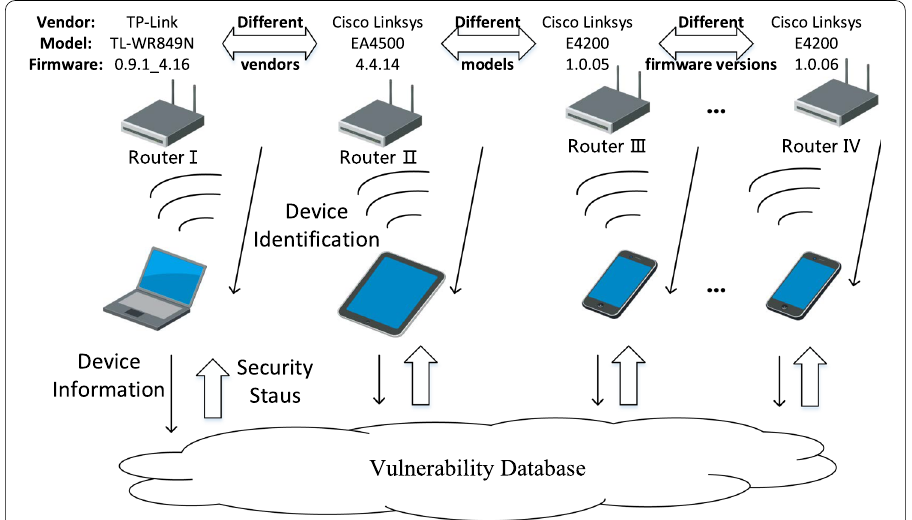
Fig. 1 The example of application